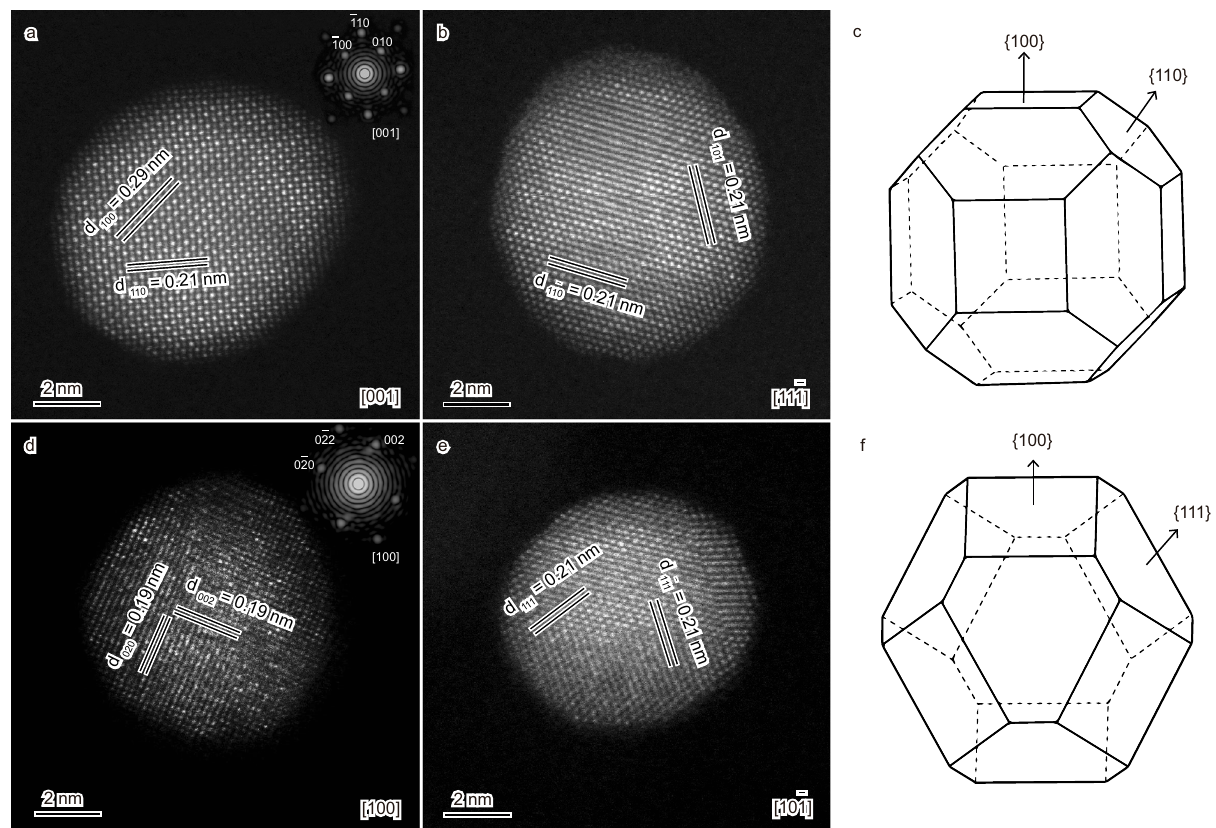
Fig.2|GeometricstructuresofthePdCunanoparticles.a – c STEMimagesofthe B2 particle viewed along the [001] ( a ) and [11 (cid:1) 1] ( b ) directions and the projected morphology ( c ) that is enclosed by twelve {110} facets and six {100} facets. d – f STEM images of the fcc particle viewed along the [100] ( d ) and [10 (cid:1) 1] ( e )